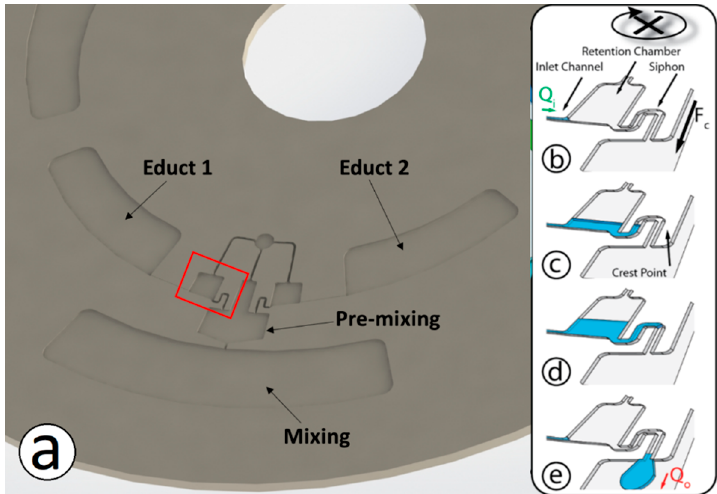
Figure 1. Working principle of the flow discretization structure. Subfigure ( a ) shows 1/3rd of a typical disc. Discs are manufactured to contain three identical mixing structures. The primary chambers are also labelled. Subfigures ( b – e ) illustrate the flow break-up principle. Under the impact of the centrifugal field, liquid flows through an inlet channel at a flow rate Q i into the retention chamber ( b ) where it accumulates ( c ). Once the liquid level has passed the crest point of the siphon, the valve opens and liquid exits at a flow rate Q o ( d ). When the chamber is empty, the liquid column breaks and the cycle resumes ( e ).